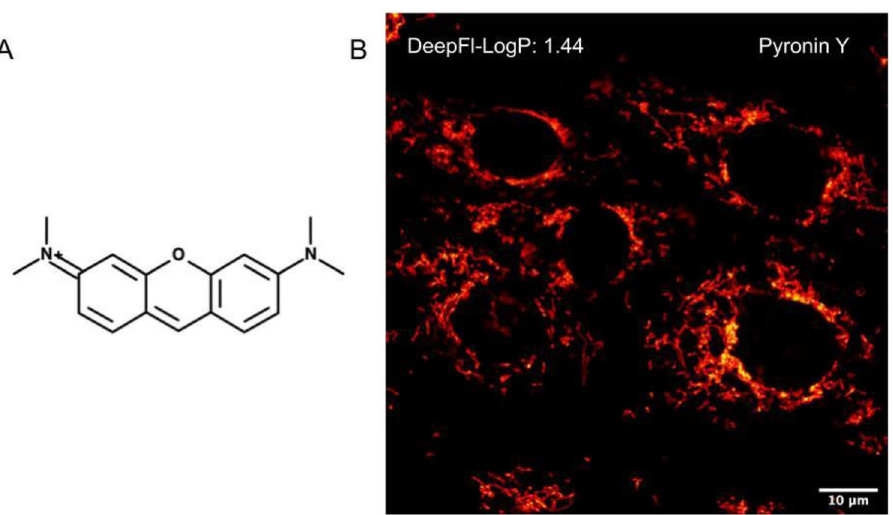
Figure 5. Pyronin Y confocal imaging of live cells. ( A ) Chemical structure of the Pyronin Y dye. ( B ) Confocal image of mitochondria in living Vero cells stained with the Pyronin Y (1 µM). Scale bar is 10